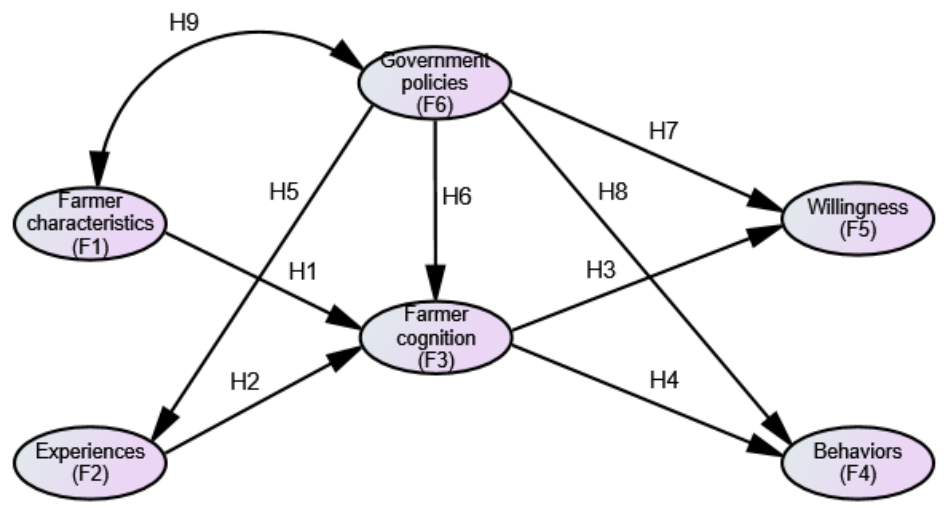
Figure 1. Model of farmers’ participation willingness and behaviors regarding EIL mechanisms.